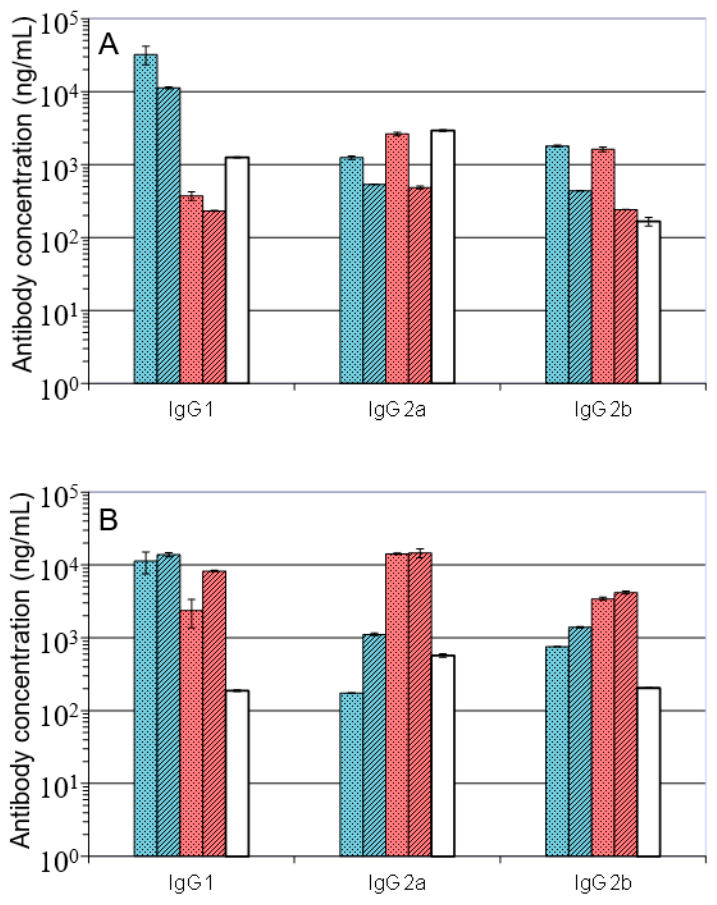
Figure 3. IgG isotype of antibody responses to subunit proteins. Pooled sera from the 3rd bleed of selected groups described in Figure 1 (5 animals per pool) were applied to ELISA plates coated with A27 ( A ) or B5 ( B ) proteins in triplicate wells. IgG isotypes were quantitated with isotype specific secondary antibodies, and data fitting to standard curves for each isotype. A27/B5/alhydrogel ( ); A27/A33/B5/alhydrogel ( ); A27/B5/CpG ( ); A27/A33/B5/CpG ( ); VACV Lister ( ); Data is